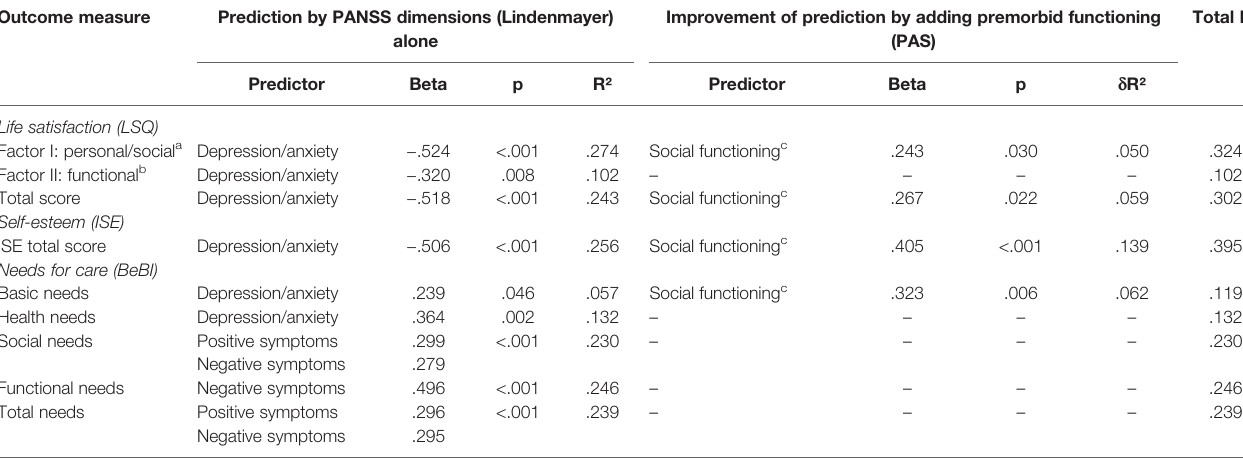
TABLE 6 | Prediction of subjective outcome by psychopathology and premorbid adjustment (multiple linear regression analysis). Outcome